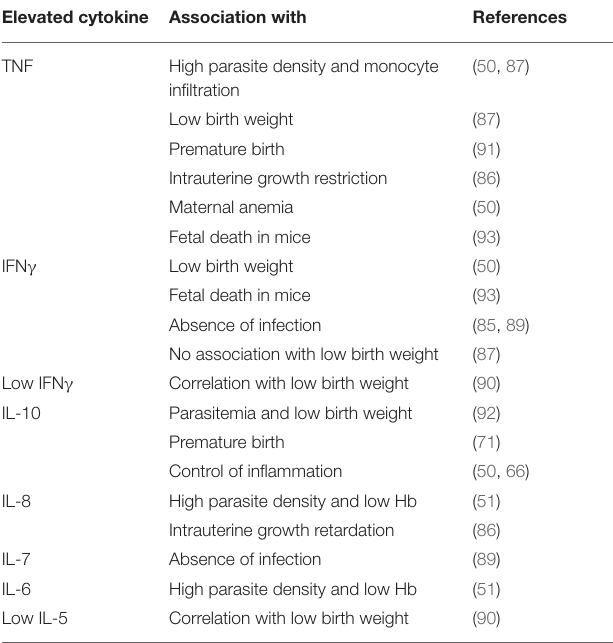
TABLE 1 | Associations of cytokines with clinical parameters in P. falciparum infections in pregnancy. Elevated cytokine Association